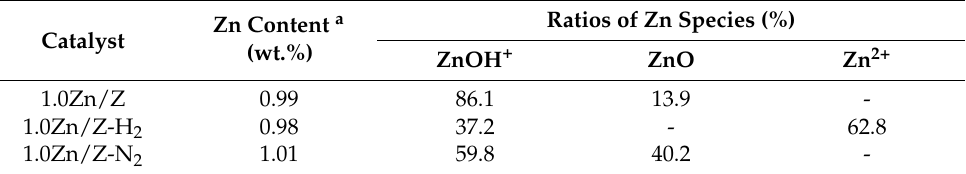
Figure 6. XRD patterns in range of 30–40° of ZSM-5 samples treated in different atmosphere and ZnO ( a ); fittings of Zn 2 p 3/2 peaks in XPS spectra of ZnO and ZSM-5 samples treated in different atmosphere ( b ); methane conversion and BTX selectivities of MTA and co-reaction over HZSM-5 and ZSM-5 samples treated in different atmosphere (0.67 g catalyst, 85 mL·min −1 mixed gas of N 2 and CH 4 , 0.045 mL·min −1 methanol flow rate, the methanol to methane molar ratio is 0.4, TOS = 10, 20, 30 min) ( c ); methane conversions with a change of ion-state Zn ratios by HZSM-5, 1.0Zn/Z, 1.0Zn/Z-H 2 and 1.0Zn/Z-N 2 ( d ). Table 4. Zn content of 1.0Zn/ZSM-5-25-IM catalyst calcined by different